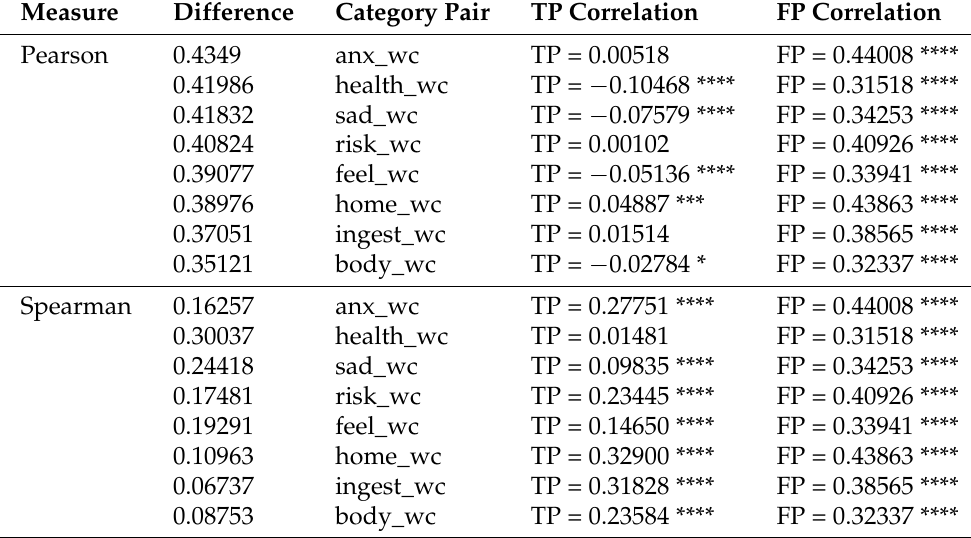
Table 46. Word count and Anxiety, Health, Sadness, Risk, Feel, Home, Ingestion, Body in All.